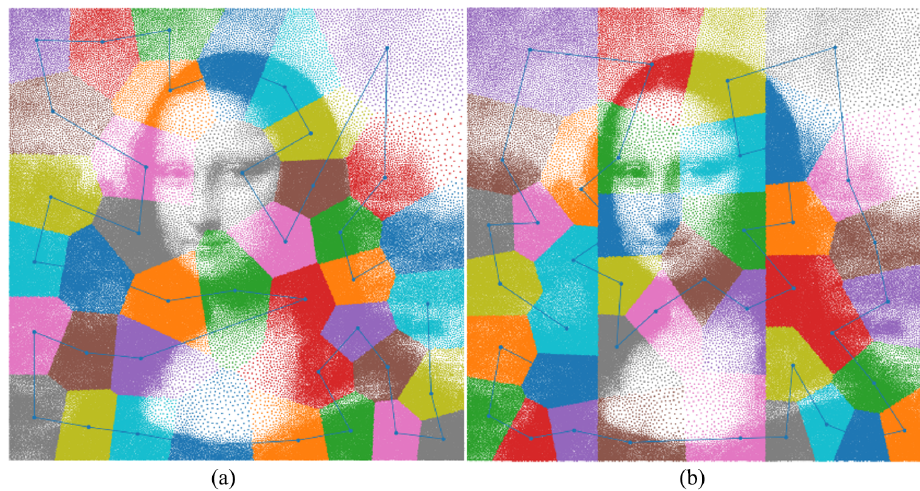
Figure 5. Visible top layered algorithm of super computer ( a ) and personal computer ( b ).